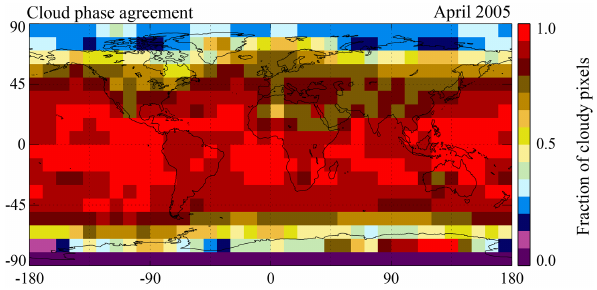
Figure 6. Sensitivity of cloud top 660nm reflectance to CER, plot- ted as a function of COT. Solid lines denote reflectance for the phase-dependent CER assumptions for liquid (red, CER = 12µm) and ice (blue, CER = 30µm) phase. Dotted lines denote ± 1 σ of reflectance assuming CER is uniformly distributed between 2 and 30µm for liquid and 5–60µm for